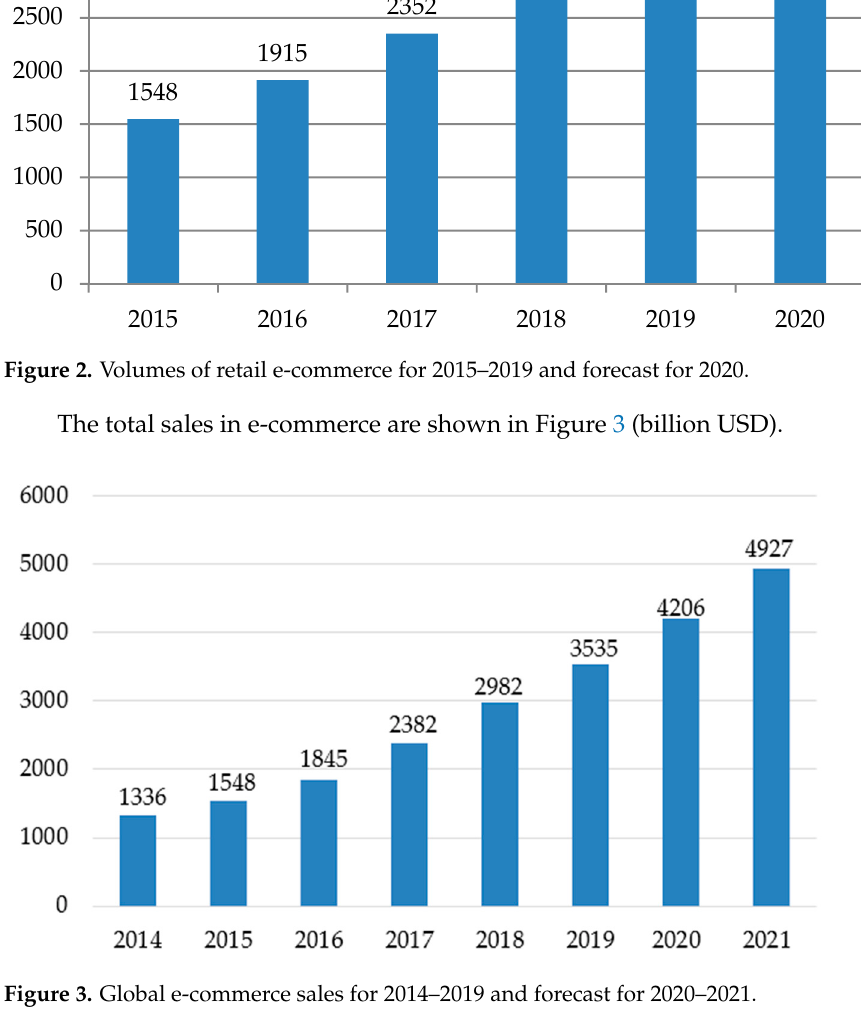
Figure 3. Global e-commerce sales for 2014–2019 and forecast for Figure 3. Global e ‐ commerce sales for 2014–2019 and forecast for 2020–2021. Figure 3. Global e ‐ commerce sales for 2014–2019 and forecast for 2020–2021.